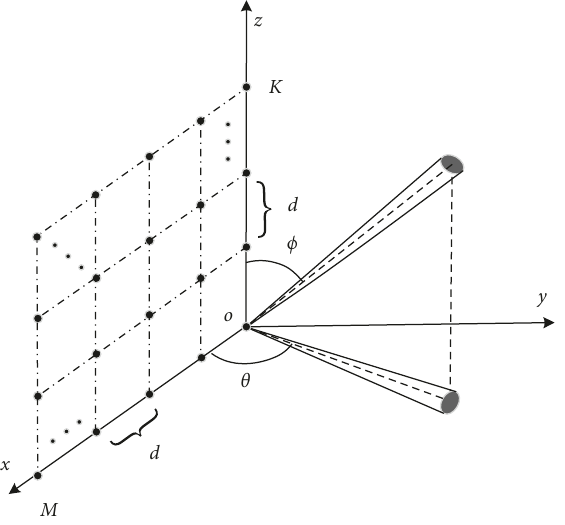
Figure 1: The uniform rectangular arrays